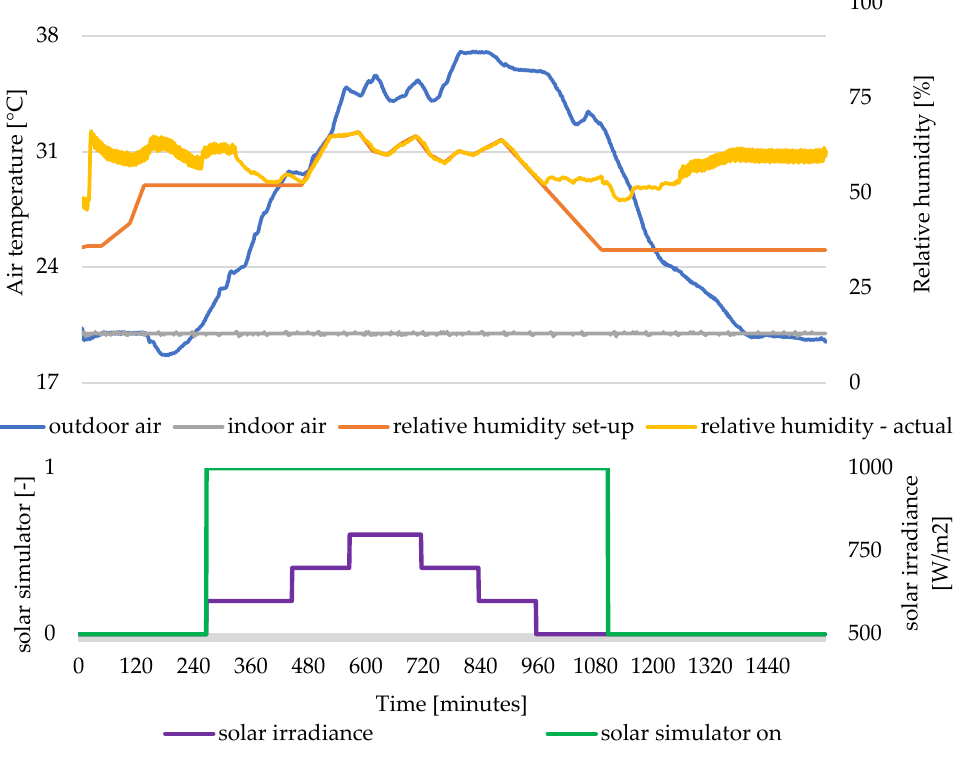
Figure 4. Boundary conditions for measurement in the climate chamber: air temperatures, outdoor humidity (setup and actual with watering of VB), and the irradiance. Outdoor air temperature from 18.6 up to 36.9 °C. Solar simulator on between minutes 270 and 1110.